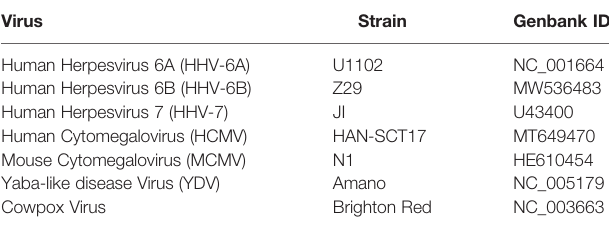
TABLE 1 | Viral genomes referenced in this